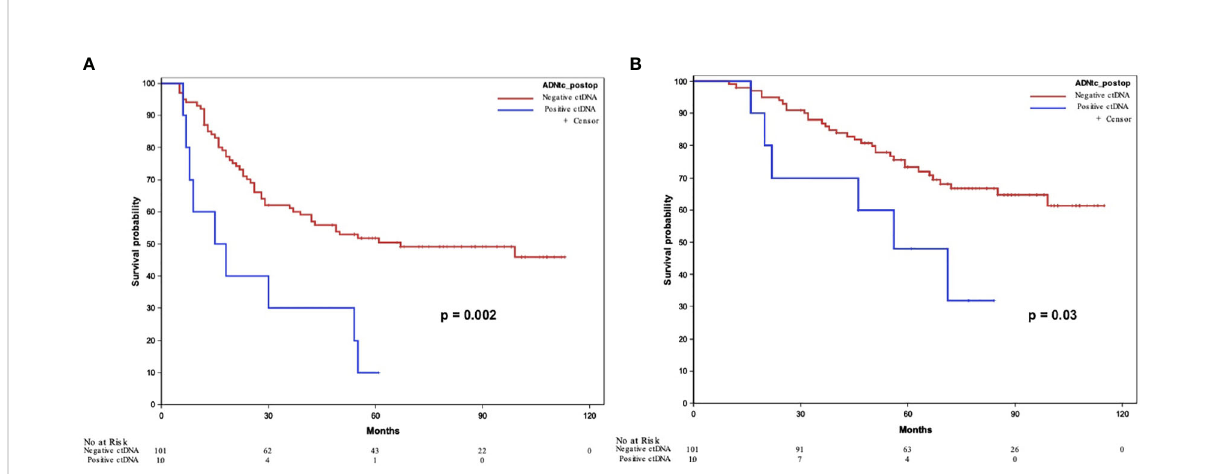
FIGURE 2 Disease-free survival (A) and overall survival (B) according to ctDNA detection. ctDNA, circulating tumor DNA.